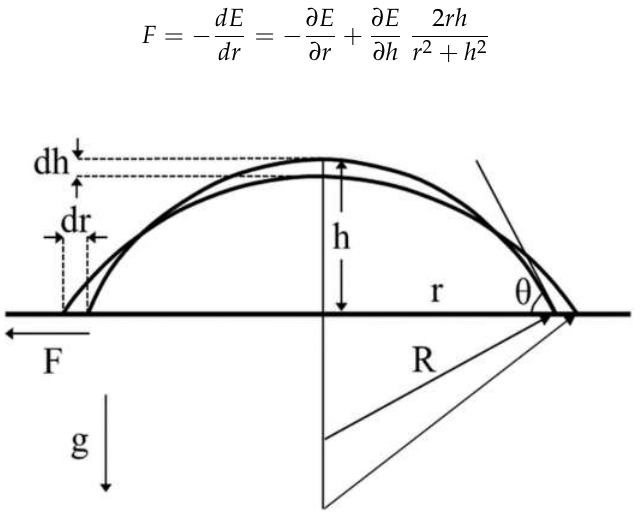
Figure 2. Spreading of droplet over a flat surface over a time period of dt .